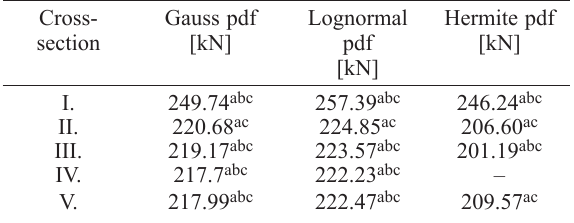
Table 5. 0.1 percentiles of LCC (design values) Cross- section